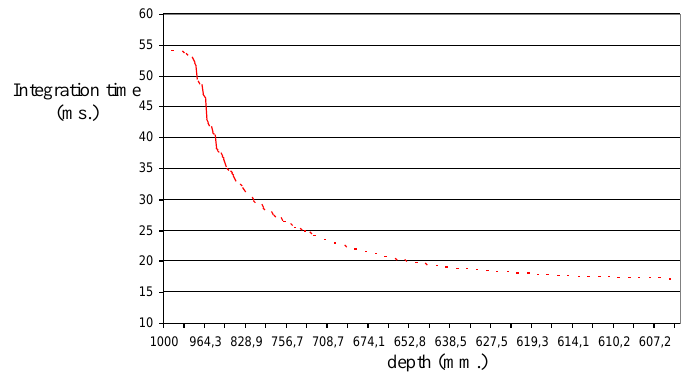
Figure 11. Integration time values at each iteration of the visual servoing task. Trajectory 1.